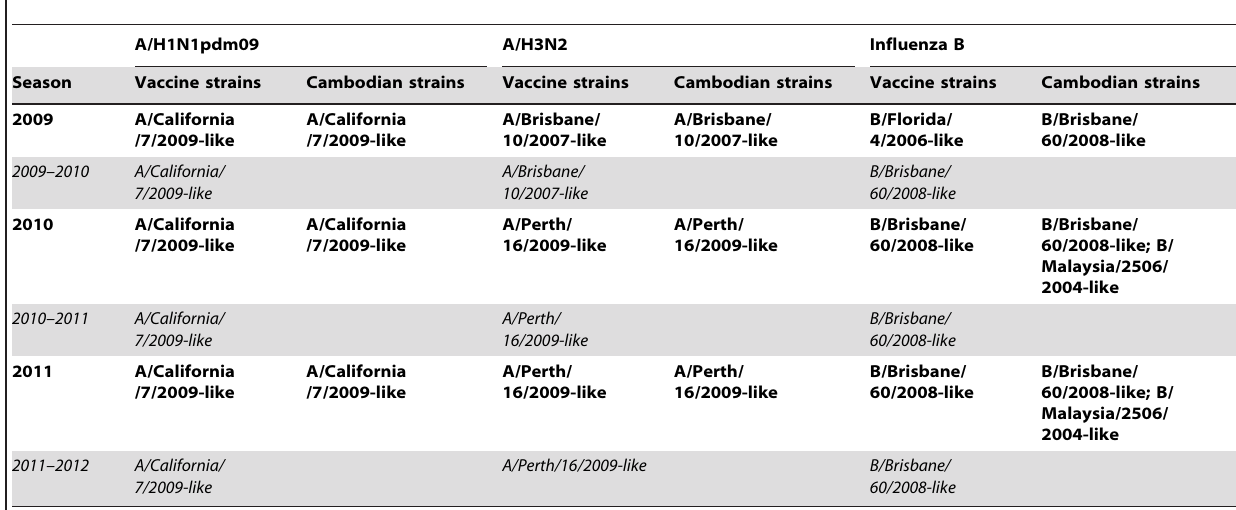
Table 2. Comparison between vaccine strains and circulating influenza strains in Cambodia from 2009 to 2011.